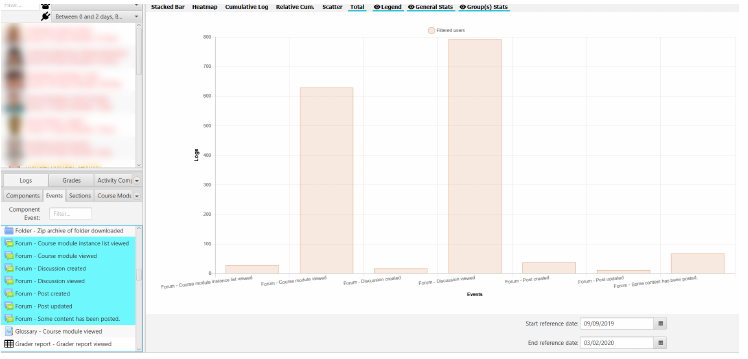
Figure 11. Total accesses by event type with